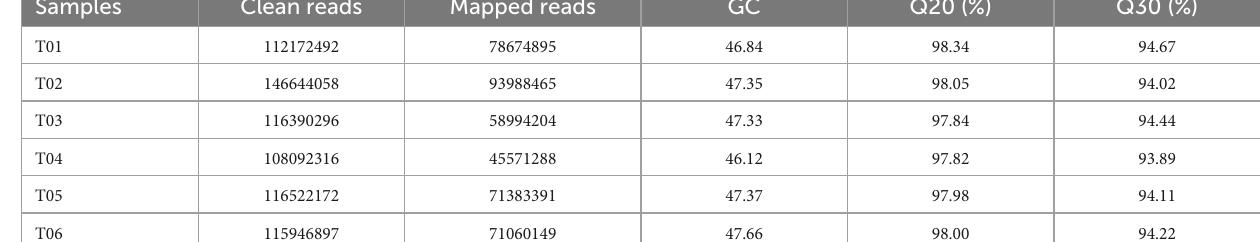
TABLE 1 Sequencing data analysis.